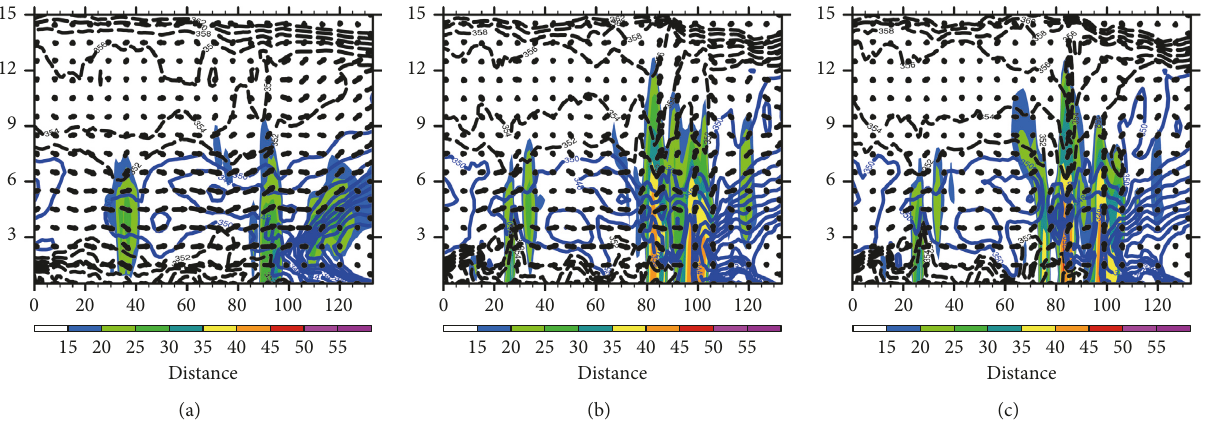
Figure 11: Cross sections of radar echoes (shaded, unit: dBZ), potential equivalent temperature θ 350K) and wind (vectors) ((a) CON, (b) RAD, and (c) RADC) along line MN in Figure 3(a) at 0300 UTC 4 July 2014. The black line: θ e horizontal axis is the distance from line EF (Figure 3(a)) (unit: 10km). The vertical axis is height (unit: ≤